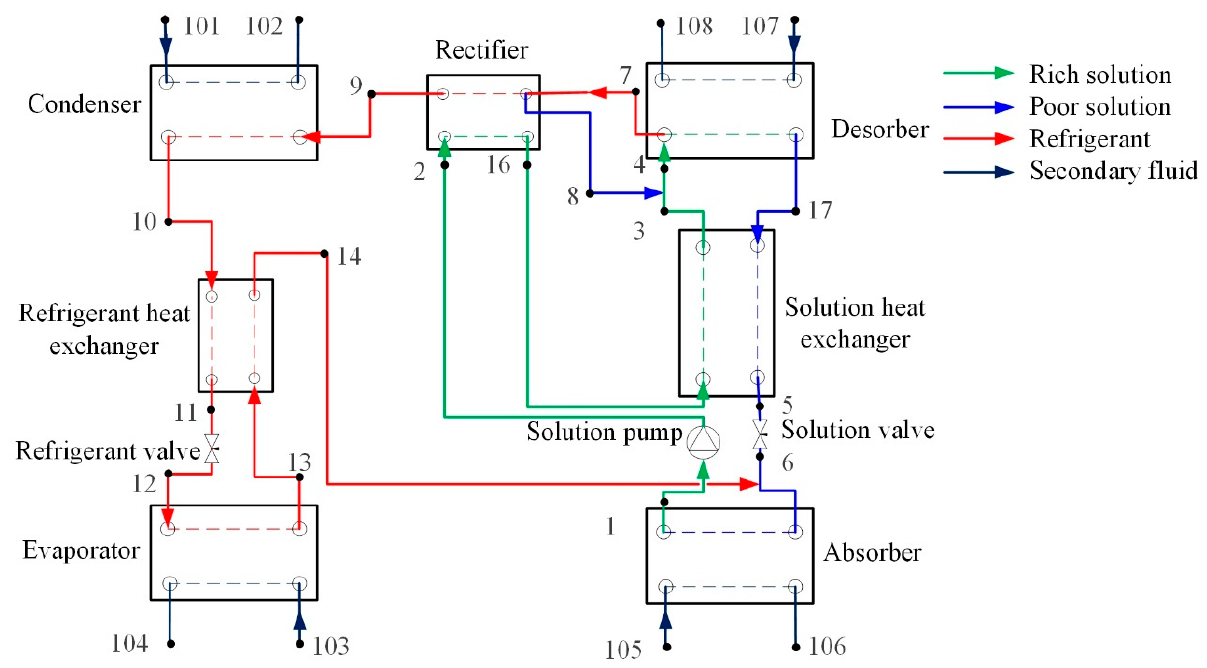
Figure 2. Flow diagram of compression-assisted ammonia/water absorption cycle.